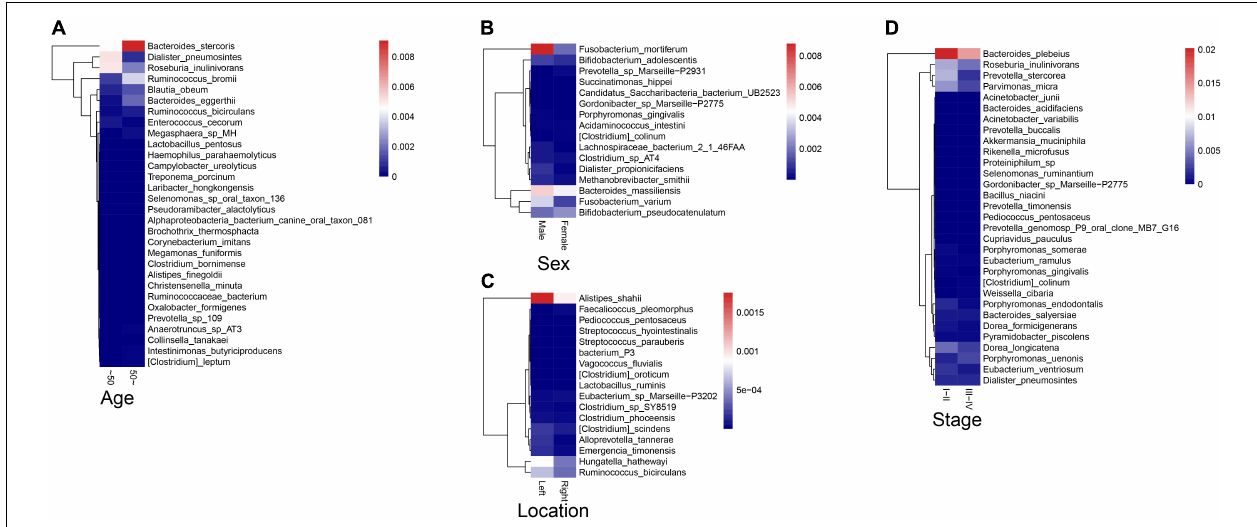
FIGURE 5 | Association between fecal microbiota and CRC clinical characteristics. (A) The correlation heatmap between intestinal microbiota and age of patients with CRC; (B) The correlation heatmap between intestinal microbiota and gender of patients with CRC; (C) The correlation heatmap between intestinal microbiota and the tumor location; (D) The correlation heatmap between intestinal microbiota and tumor